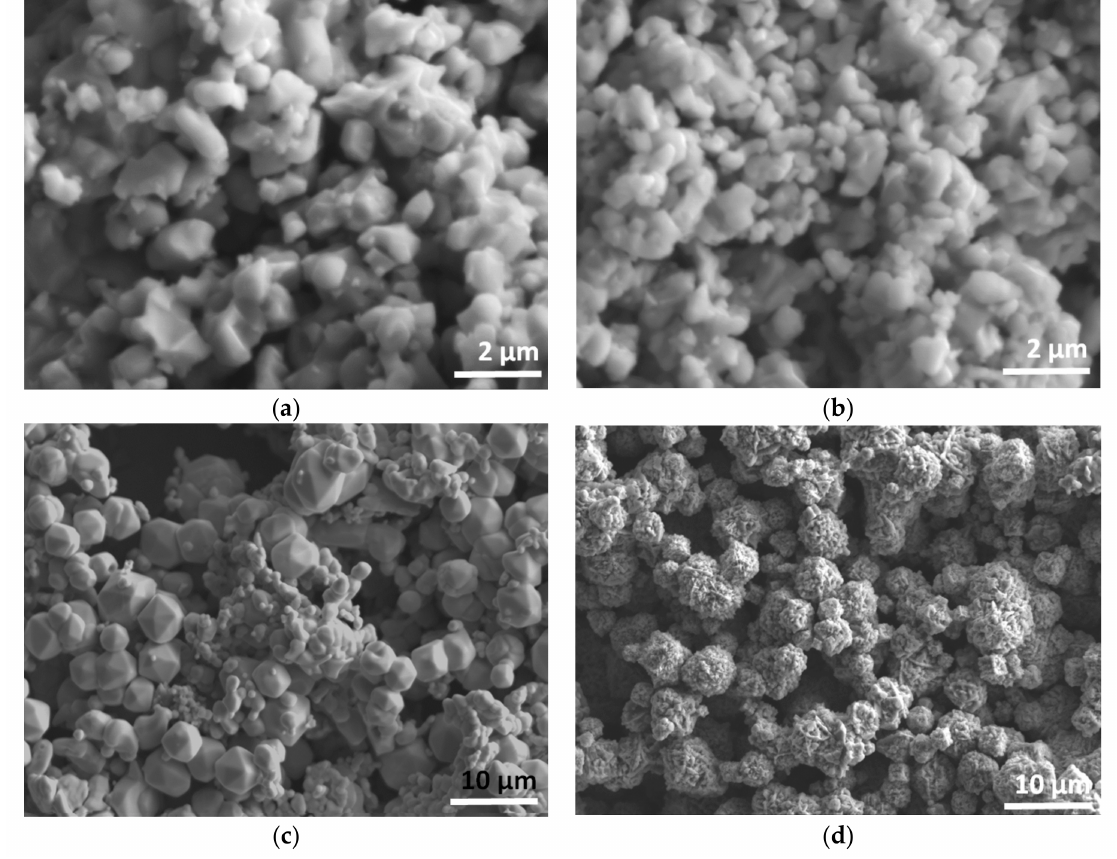
Figure 1. Morphology of the NbC starting powders, ( a ) NbC-A (11.2 wt % C) and ( b ) NbC-B (12.2 wt % C), ( c ) Mo powder and ( d ) Ni